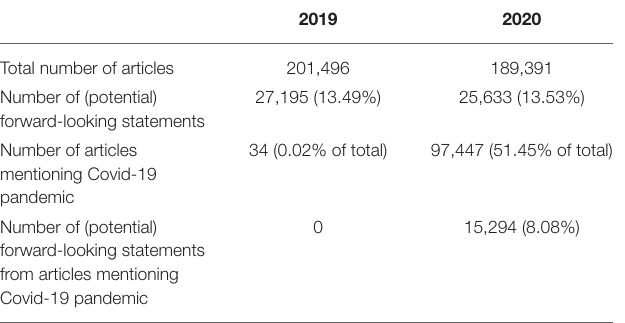
TABLE 2 | Corpus overview, results of the classification process.